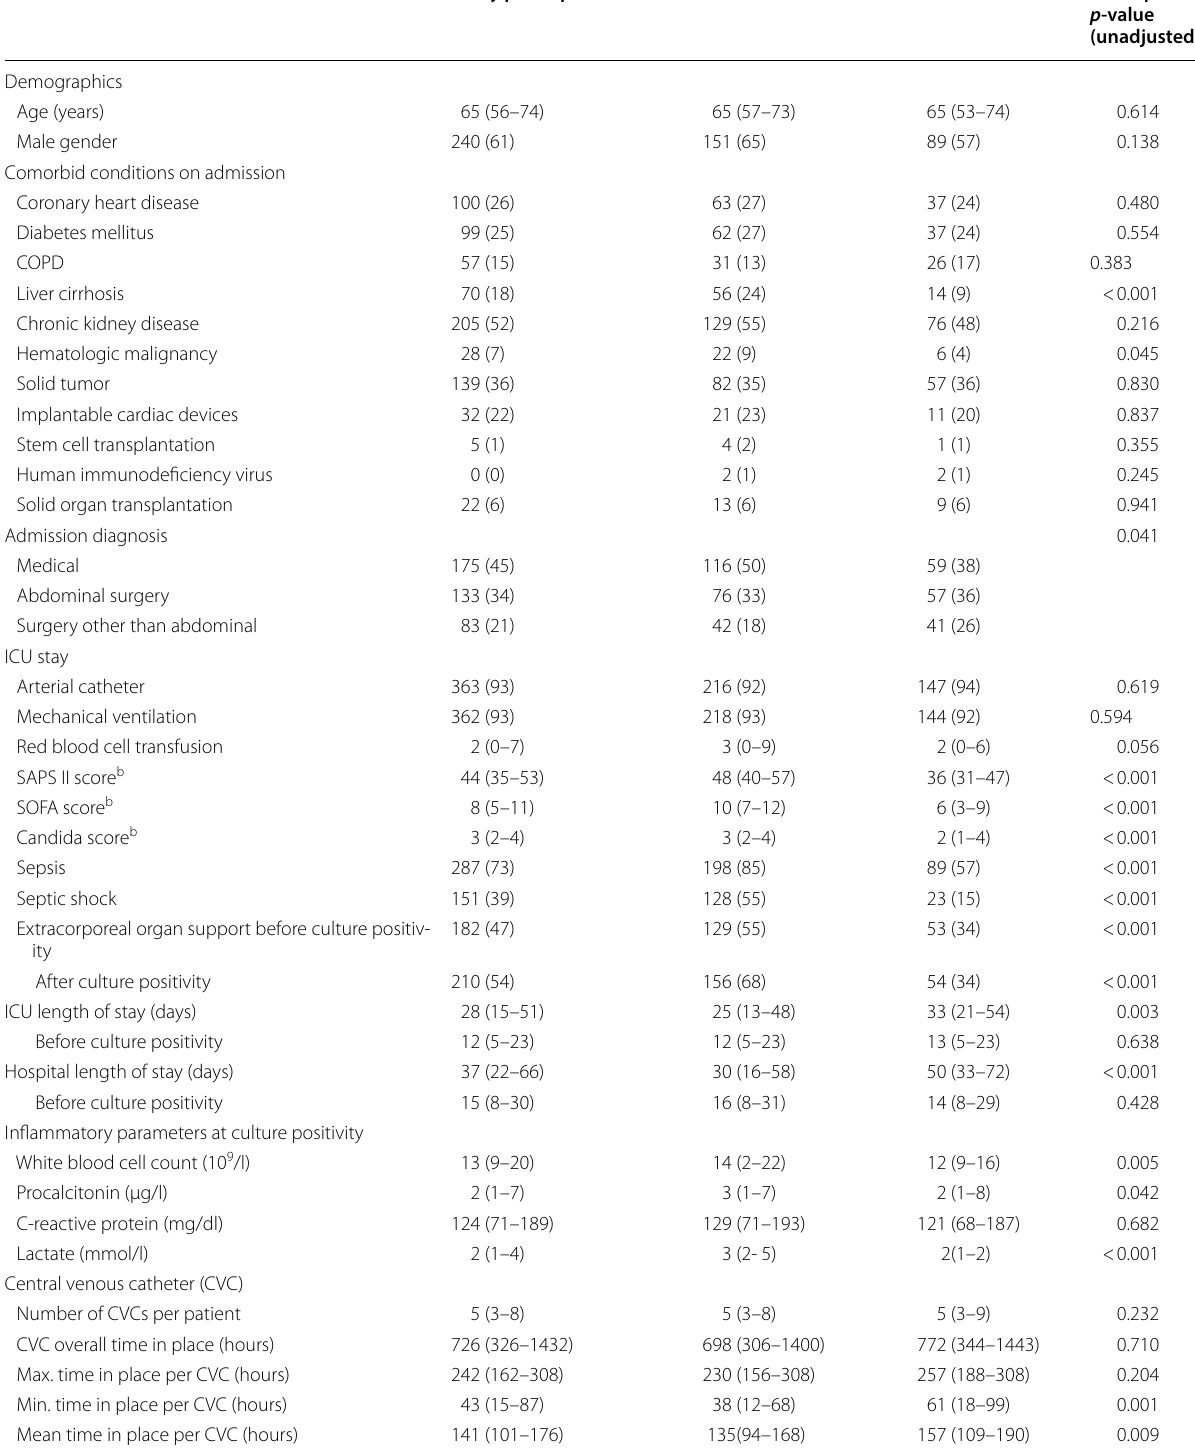
Table 1 Baseline demographic and clinical characteristics, admission diagnosis, treatment-related variables and microbiological findings in critically ill patients with laboratory-confirmed bloodstream infection with Candida spp. Continuous variables are given as median (1st to 3rd quantile), categorical variables are given as n